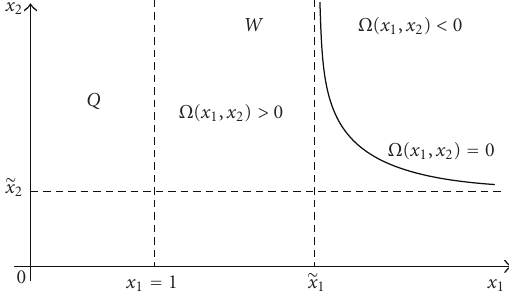
Figure 5: Allocation of signs of the function Ω ( x 1 , x 2